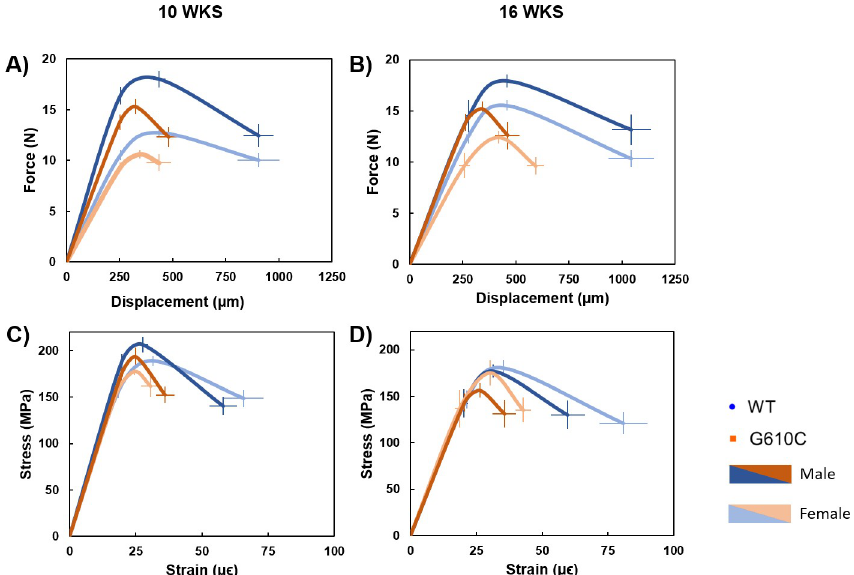
Fig 3. Schematic mechanical curves from tibial 4-pt bending tests. A) Average force-displacement plot for 10-week mice, showing weaker G610C bones with significant deficiencies in postyield and total displacement. B) Strength and deformation disparities continued with the 16-week bones. C) Average stress-strain plots for 10-week mice demonstrates that G610C tissue breaks at lower strains than WT bones. D) This brittle phenotype is maintained at 16-weeks of age. Data points are mean values +/- standard error.